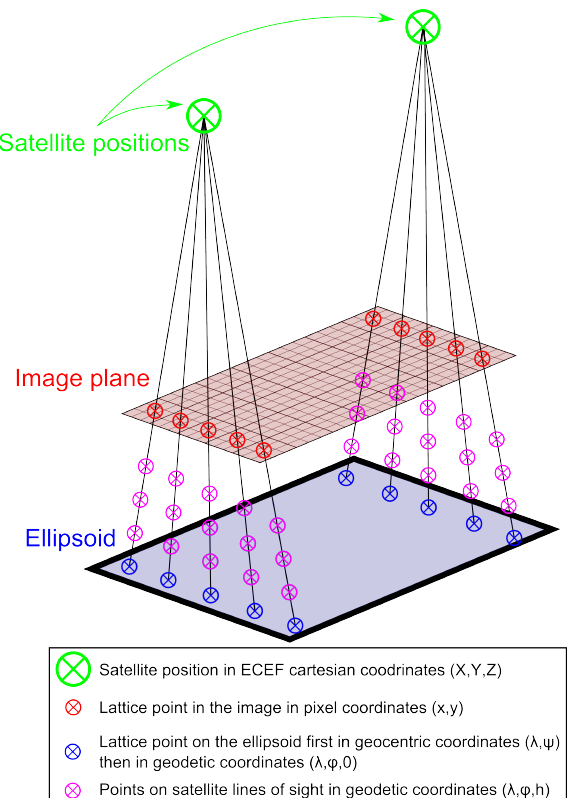
Figure 3: Satellite positions and associated lattice points in im- age and geographical coordinates and 3D GRID created from the lattice points.